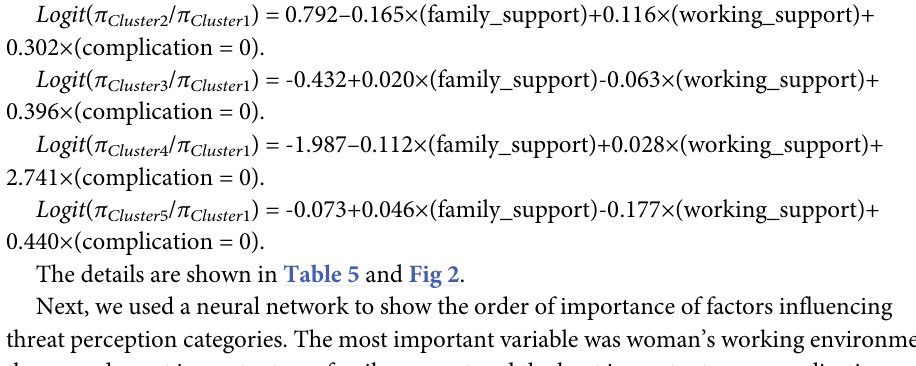
Table 5. The influence of demographic variables on five latent clusters by multinomial logistic regression with five latent clusters as independent variables and demographic as covariates and factors variables. five latent clusters a B Std. Error Wald P OR 95% Confidence Interval for